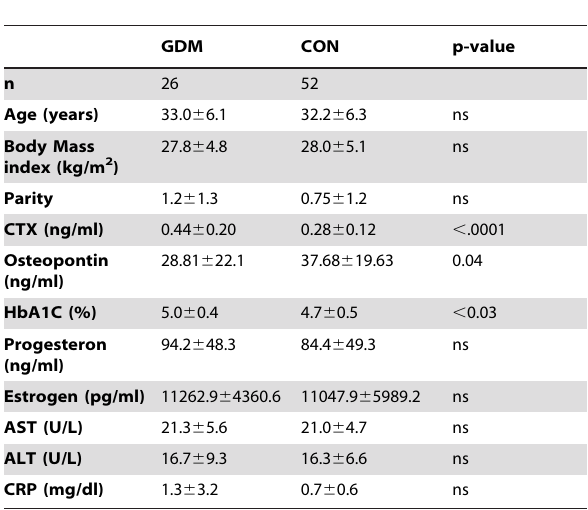
Table 1. Baseline characteristics and metabolic parameters between 24–28th gestational weeks in women with gestational diabetes (GDM) and healthy controls [CON] [4]